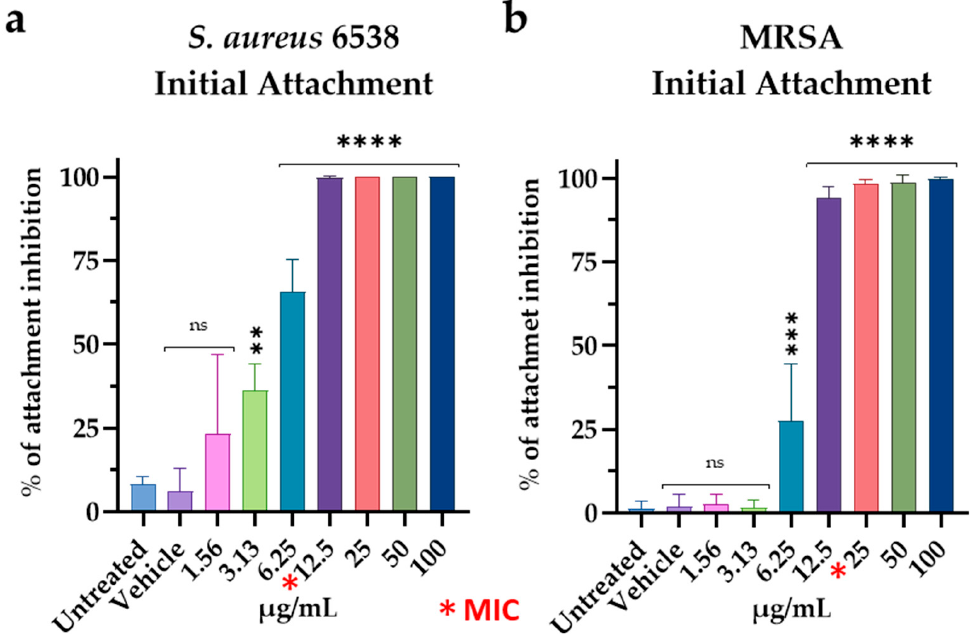
Figure 4. M15RL interference with the attachment of ( a ) S. aureus 6538 and ( b ) MRSA to the substrate. Statistical analyses were determined by ANOVA with Dunnett’s test for multiple compari- sons. Significances are referred to the untreated bacteria. **** p < 0.0001, *** p < 0.0002, ** p < 0.0021, ns (not statistically significant).